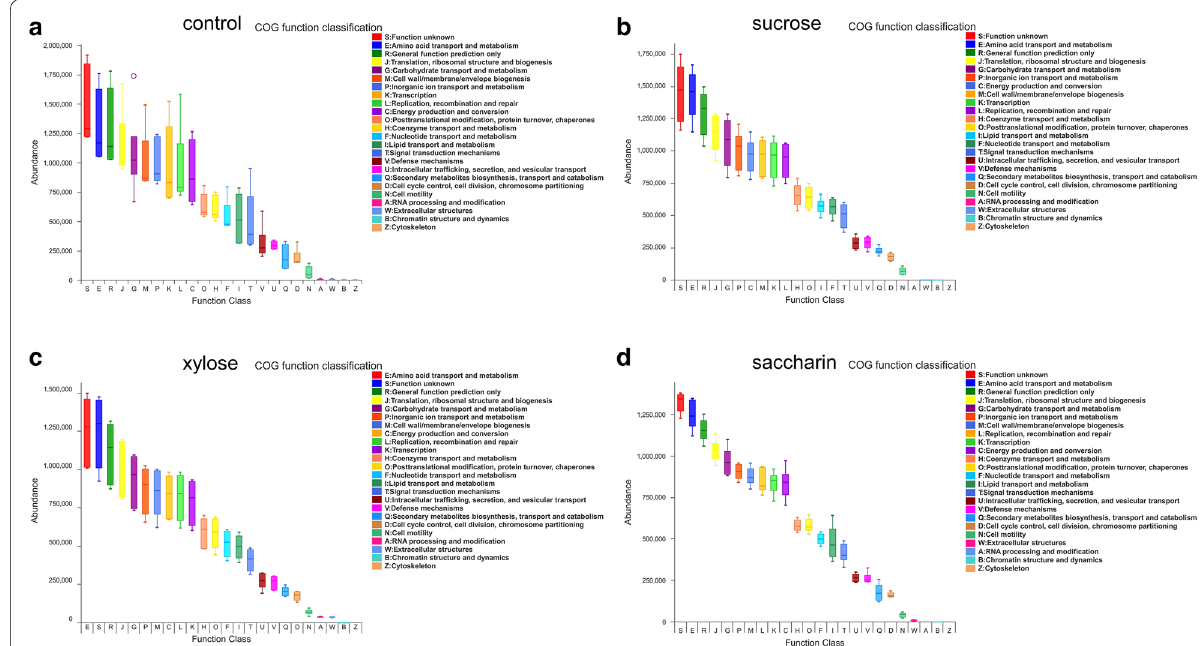
Fig. 4 Box diagram describing COG functional classification statistics drawn based on the results of the PICRUSt functional prediction